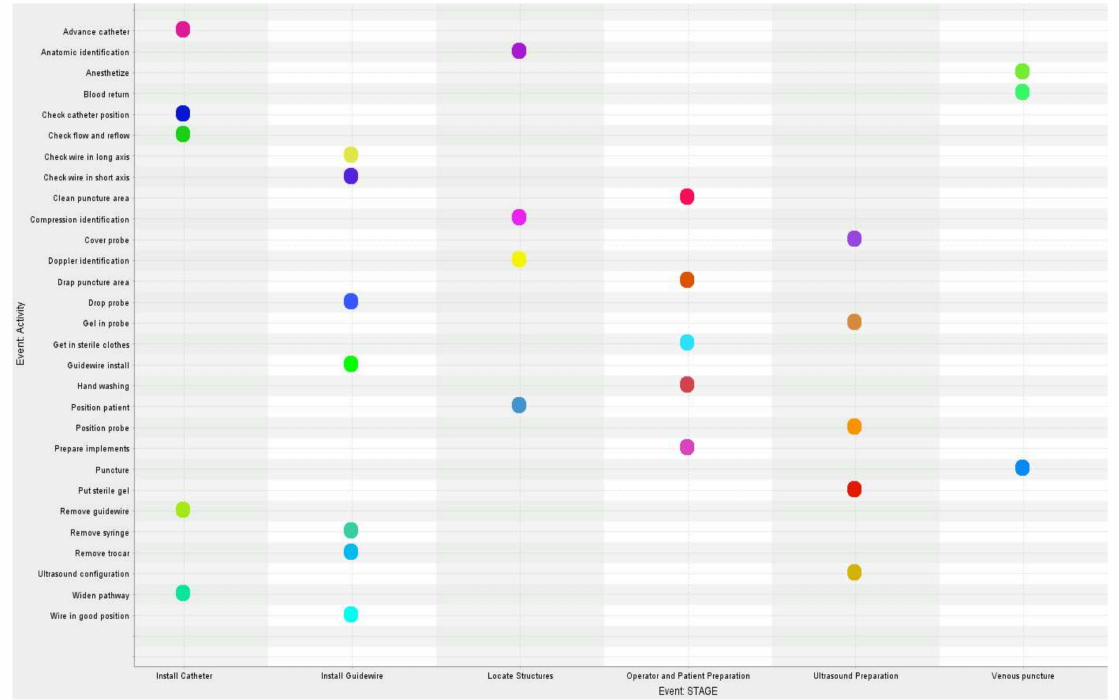
Figure 3. Activity representation of different stages of CVC installation with color-coding (Each dot represents the activity performed at independent stages, and lines present connection between